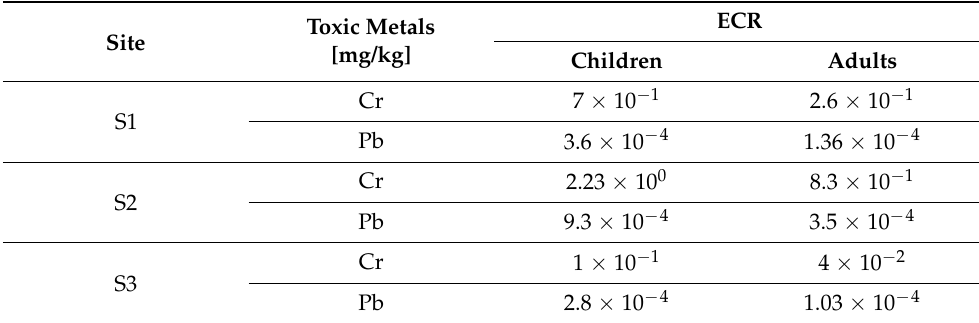
Table 11. ECR values for children and adults for the sediments at all the studied sites: S1 “Bł˛ekitna Laguna”, S2 “Huta”, and S3 “Mała Szwecja” [mg/kg].